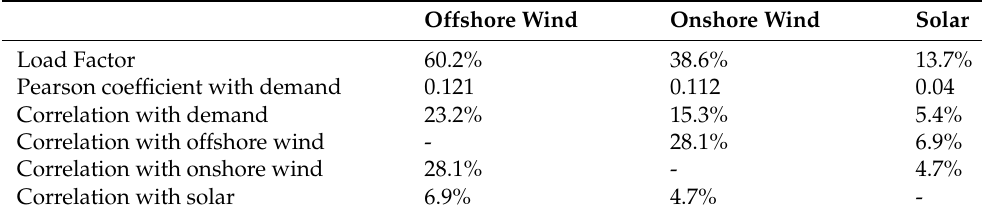
Table 4. Metrics for the time profiles of the offshore wind, onshore wind and solar generation profiles. Metrics include load factor, Pearson coefficient and correlation with demand, and correlation with the other